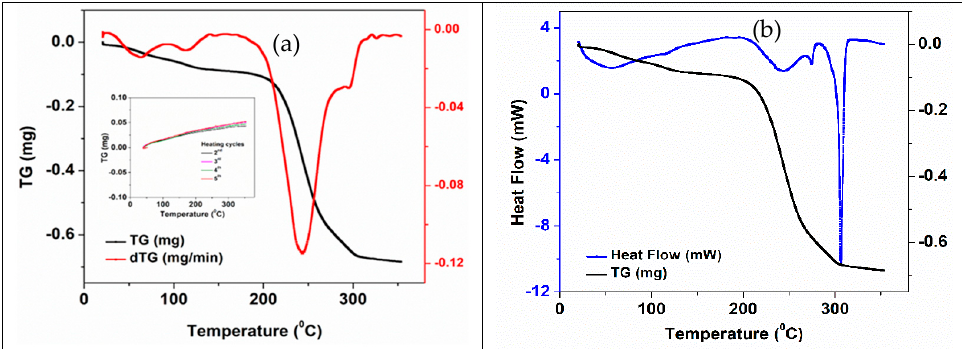
Figure 10. Thermal curves of the NaNO 3 -impregnated 3D ZnO-CNT structure: ( a ) TG-DTG—first heating cycle. The inset shows the TG curves—2nd–5th heating cycles; ( b ) TG-DSC—first heating cycle.